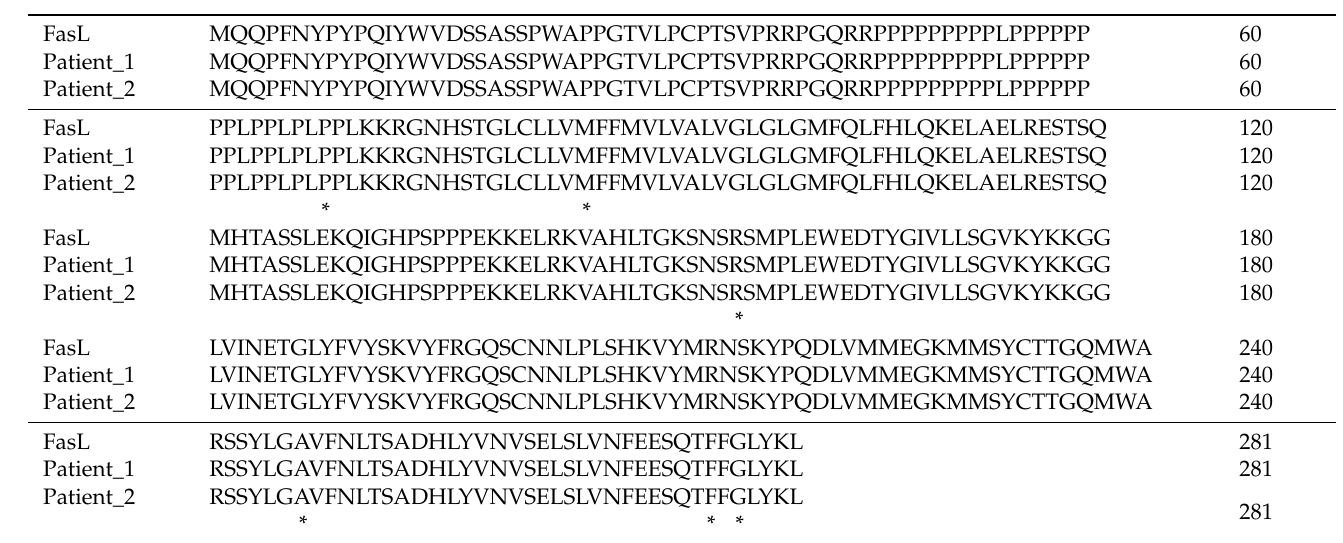
Table 4. Amino acid sequence alignment of FasL from the patients and the reported in the UniProtKB– P48023. *, amino acids which mutation has been implicated in ALPS, P69A [19]; M86V, R156G [20]; A247E [21]; F275L [20]; G277S